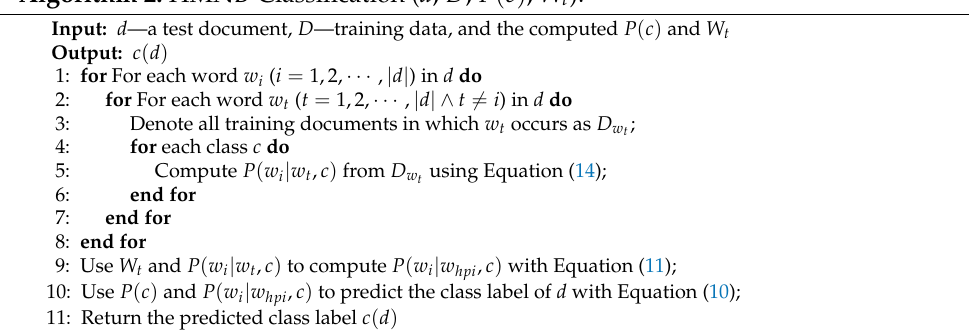
Algorithm 2: HMNB-Classification ( d , D , P ( c ) , W t